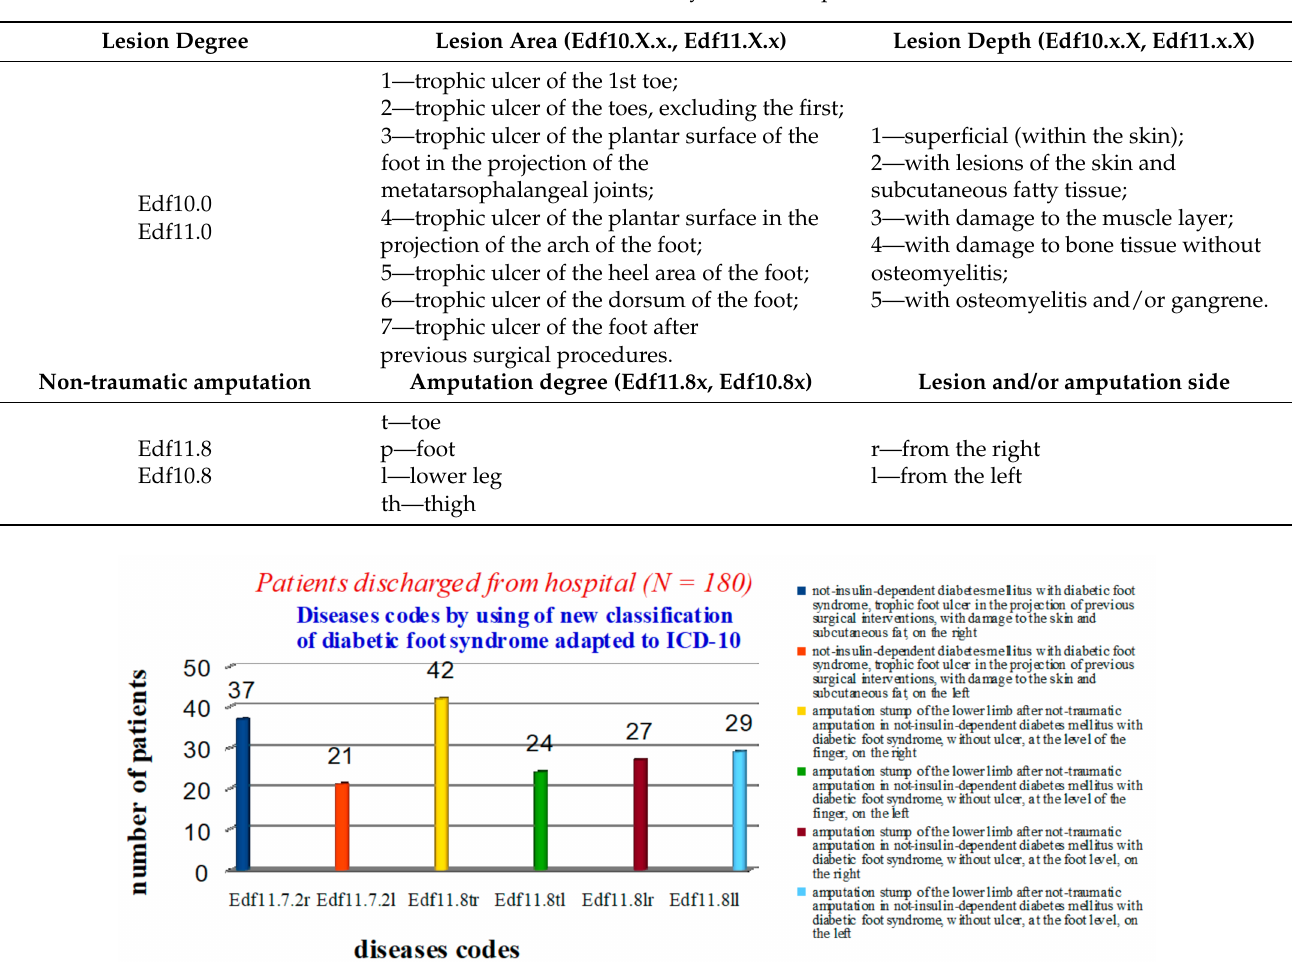
Figure 1. Statistical data on nosologies of patients discharged from the hospital. Table 1. Classification of diabetic foot syndrome adapted to ICD-10.